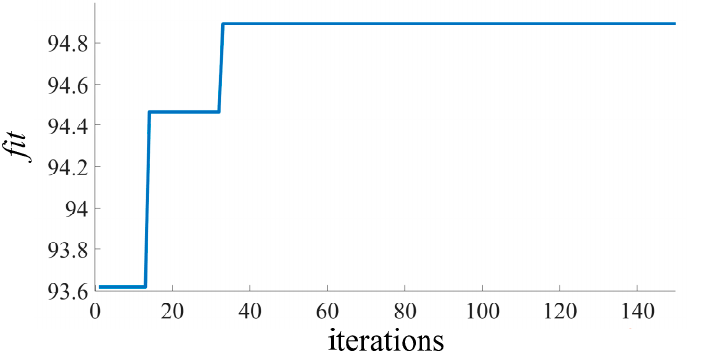
Figure 11. Iterative calculation process of main pump state identification based on EEMD-OQGA- SVM algorithm.